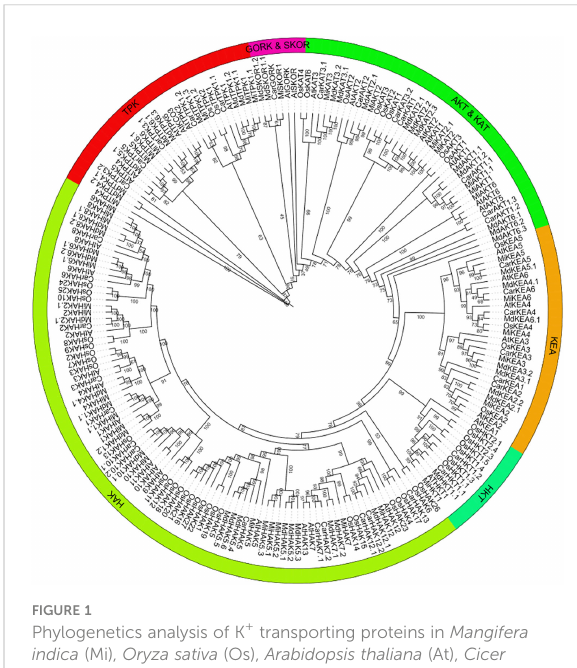
FIGURE 1 Phylogenetics analysis of K + transporting proteins in Mangifera indica (Mi), Oryza sativa (Os), Arabidopsis thaliana (At), Cicer arietinum (Car), and Malus domestica (Md). Tree was generated by MEGA-7, using 1,000 bootstrap values with the neighbor- joining